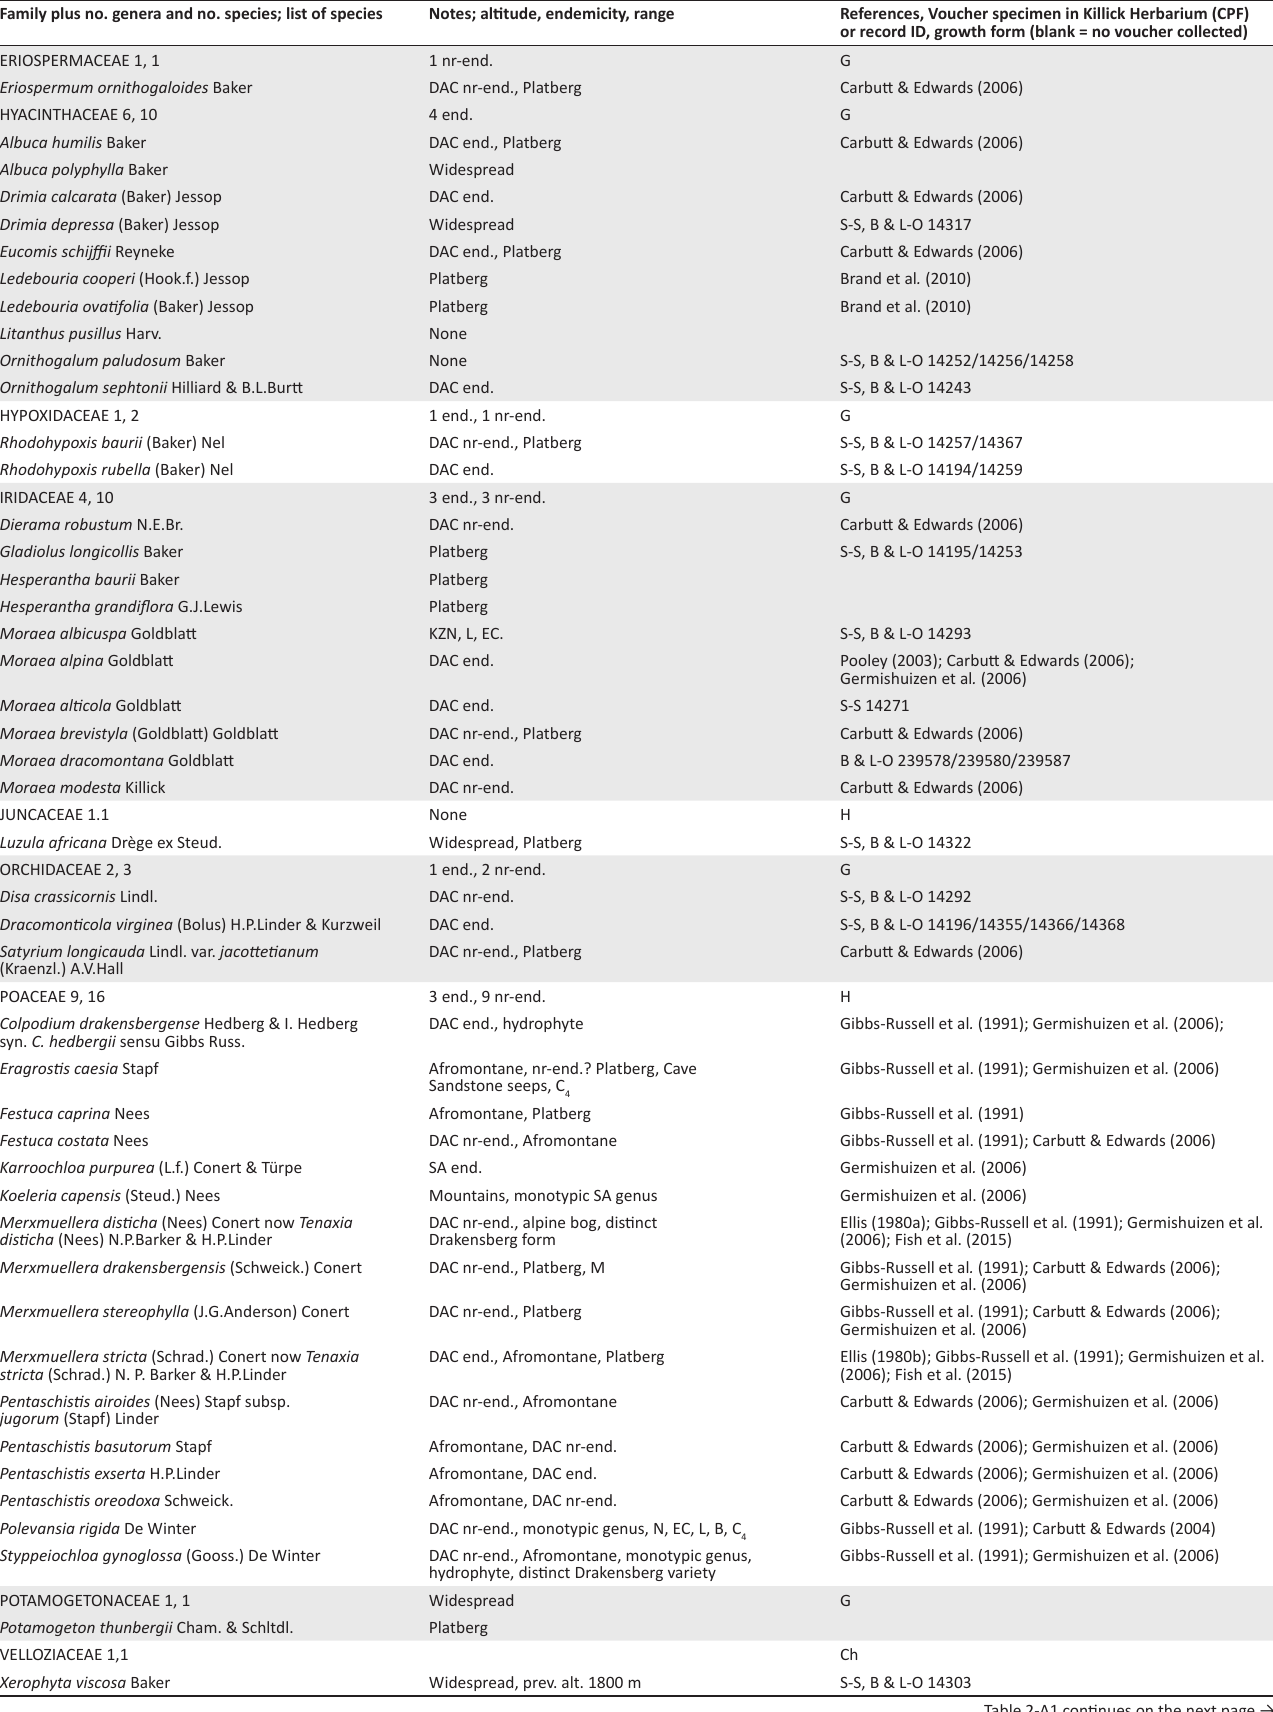
Table 2-A1 continues on the next page